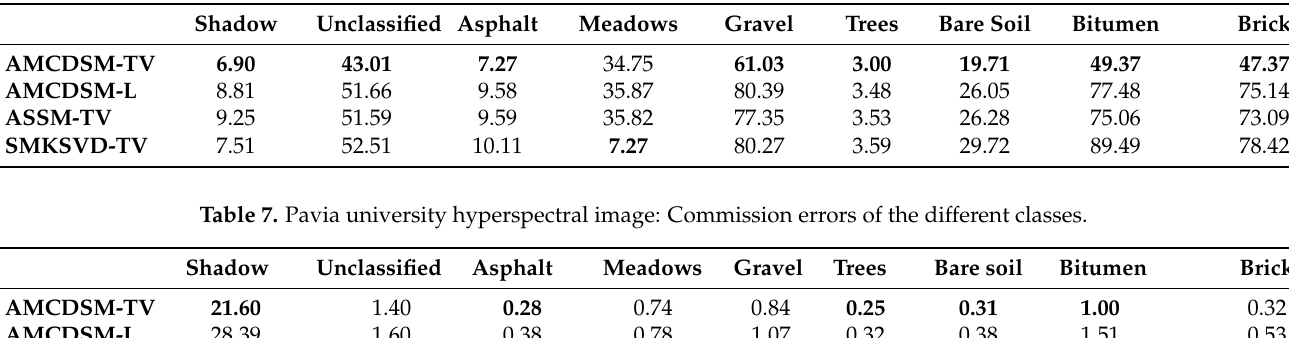
Table 6. Pavia university hyperspectral image: Omission errors of the different classes.